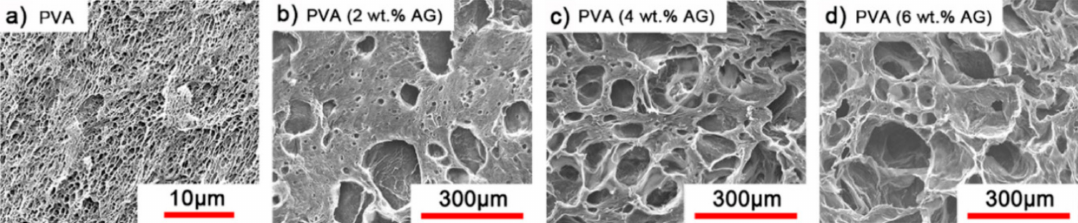
Figure 1. Scanning electron microscope (SEM) micrographs of dried ( a ) PVA hydrogel and ( b – d ) macroporous PVA hydrogels treated with ( b ) 2 wt% ( c ) 4 wt% and ( d ) 6 wt% of agarose as pore formation agent